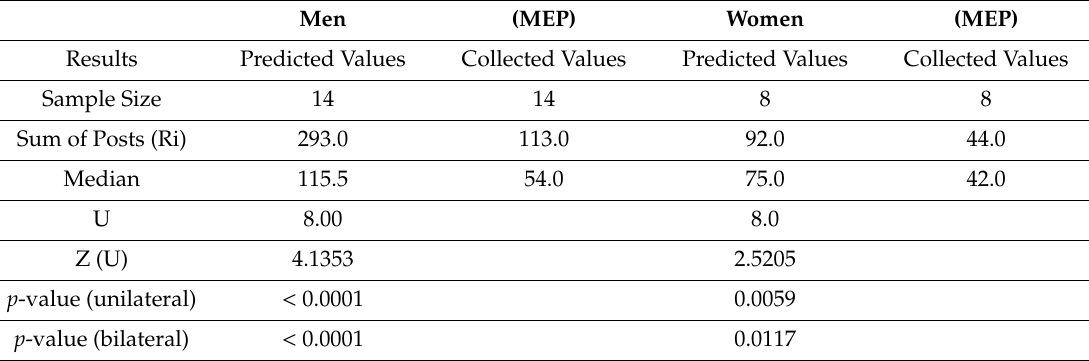
Table 2. Median values for maximum expiratory pressure (MEP) in men and